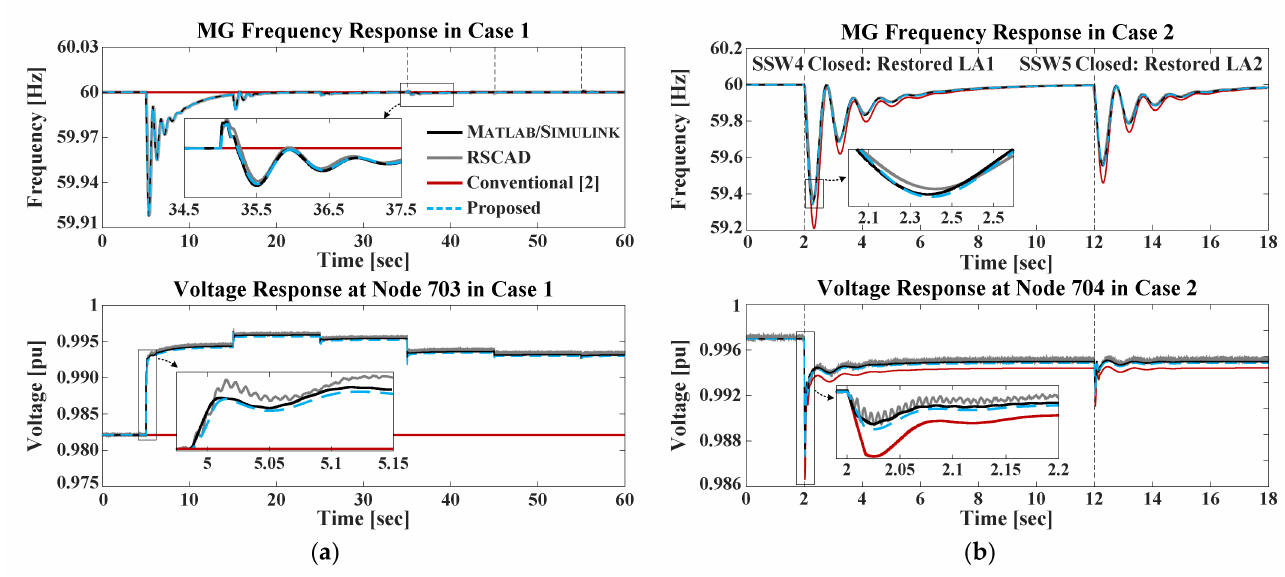
Figure 8. The grid frequency and voltage profiles of the new, conventional, and comprehensive models of NR: ( a ) Case 1 (without NR-aided load shedding/restoration) and ( b ) Case 2 (with NR- aided load restoration).